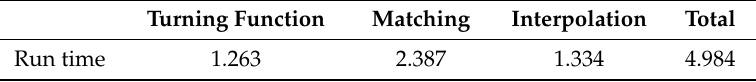
Table 3. Performance statistics of the experiment illustrated in Figure 9 (the run time is measured in seconds; n = 46; m =